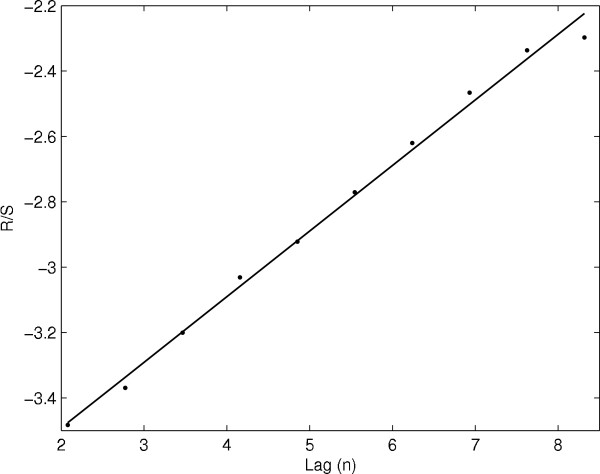
Typical R/S vs lag n plot.